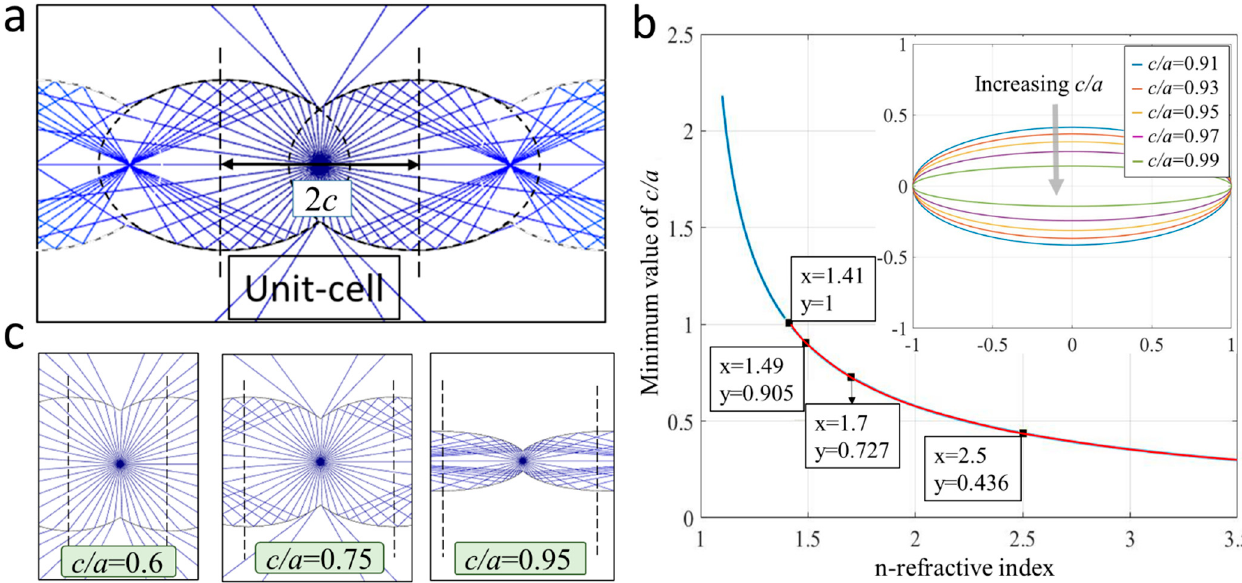
Figure 2. ( a ) A unit cell that hosts concentrated luminescent dye at the shared focal point of two ellipses. The width of the unit cell is 2C. ( b ) The minimum value of c / a for which TIR will occur for radiation emitted from the focal point plotted as a function of the refractive index of the medium internal to the ellipse (assuming the medium external to the ellipse is air) and ( c ) propagation behavior of radiation emitted from a point source located at the shared focal point of overlapping ellipses for the cases in which the index of refraction of the internal medium is n = 1.49 and the ellipse parameters are c / a = 0.6, c / a = 0.75 and c / a = 0.95.